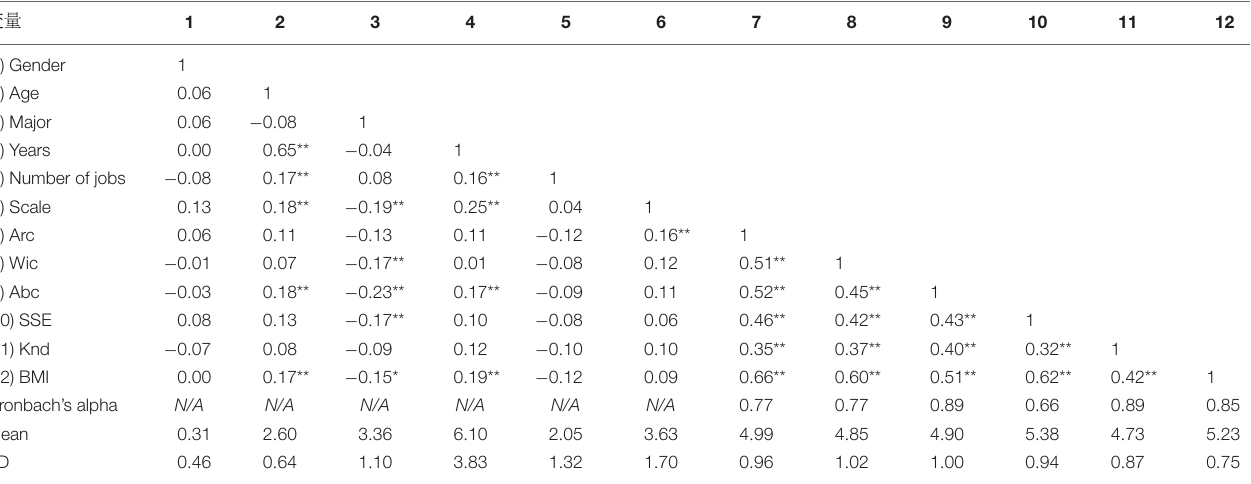
TABLE 3 | Means, standard deviations, and